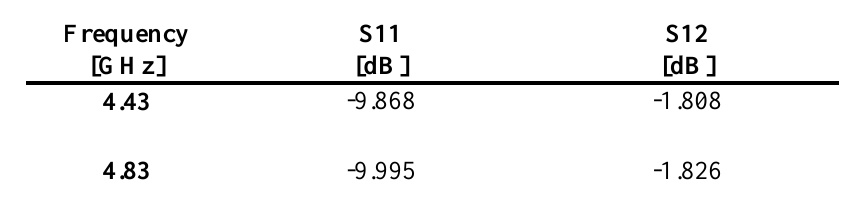
Table 3. The final